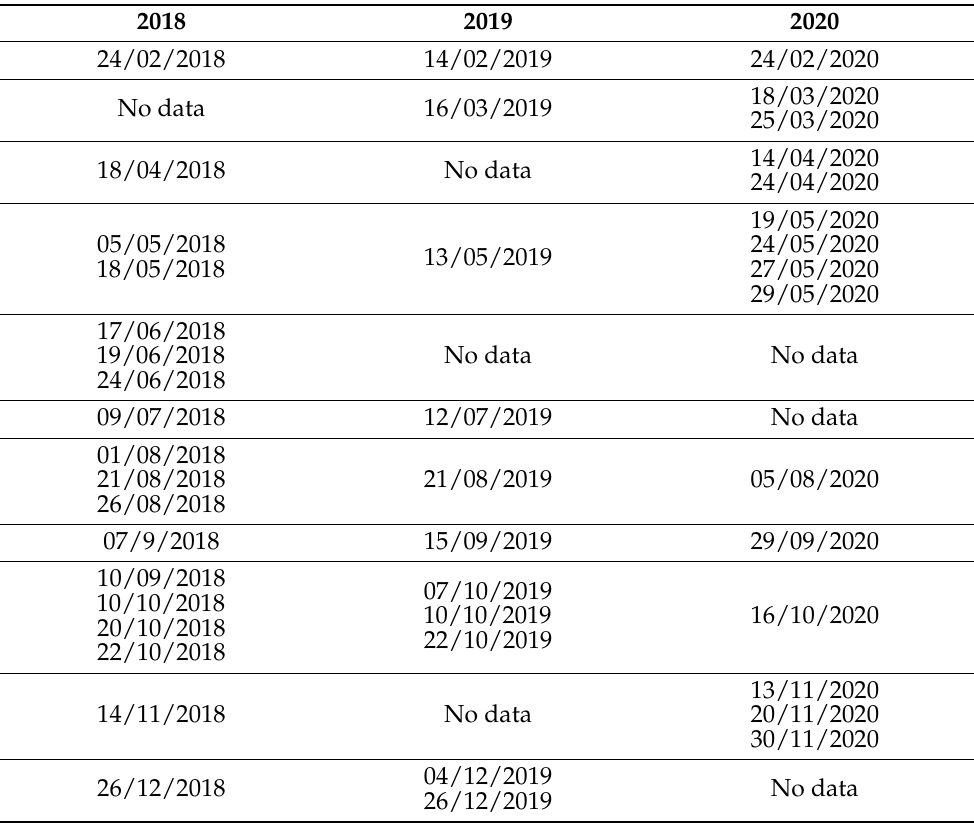
Table 1. Images acquired from the Copernicus Open Access Hub for the time period analyzed from 2018 to